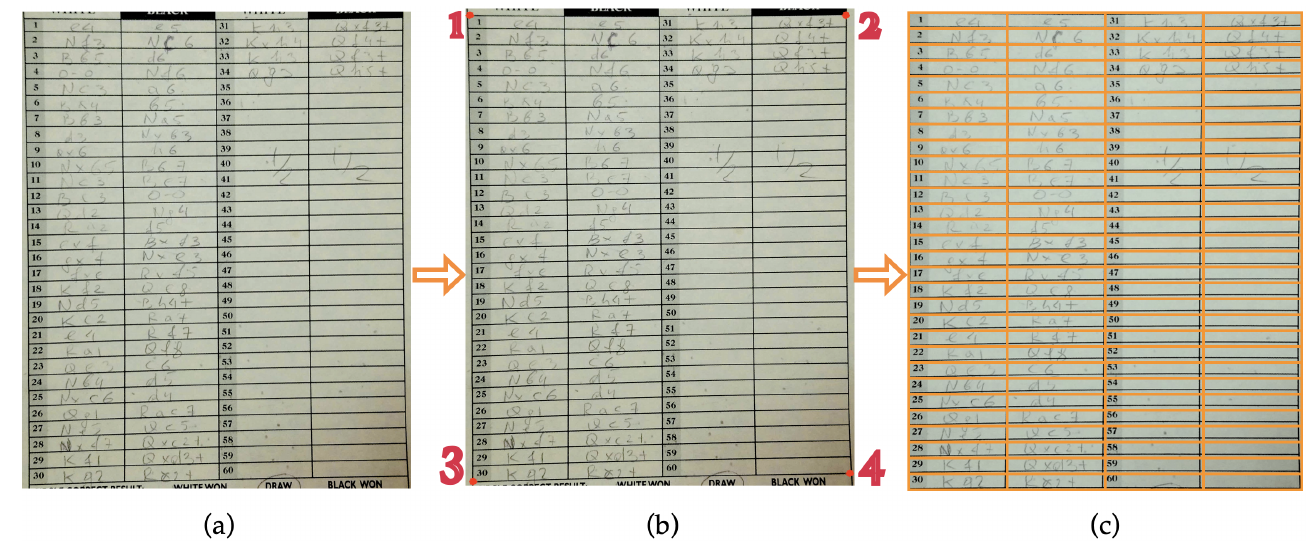
Figure 4. Four-corner-marking is an alternate method for preprocessing which requires a person to highlight the four corners of the move recording table from a chess scoresheet before or after taking a picture: ( a ) a sample scoresheet image; ( b ) marking the four corners of the table with red dots; ( c ) perspective correction and equally dividing the enclosed space to extract individual